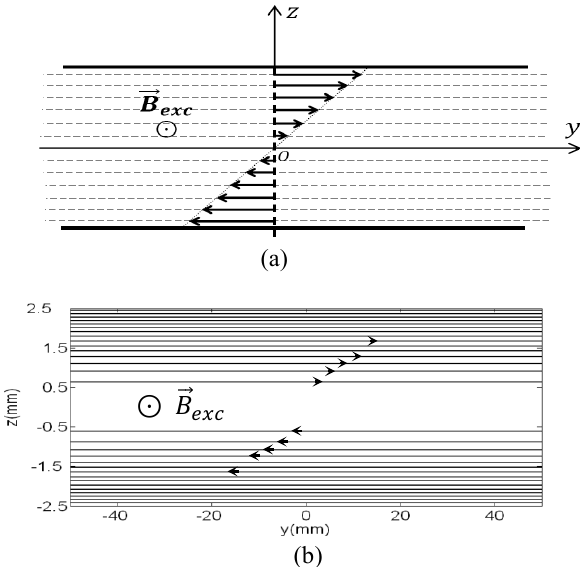
Figure 2: Description of the eddy currents densities (a) and lines (b) in the abcd plane, in the case of a flawless plate. ) (with B exc Note that the induced current is parallel to 𝑂𝑦 axis principally except at the extremities of the plate which are not shown on the figure 2